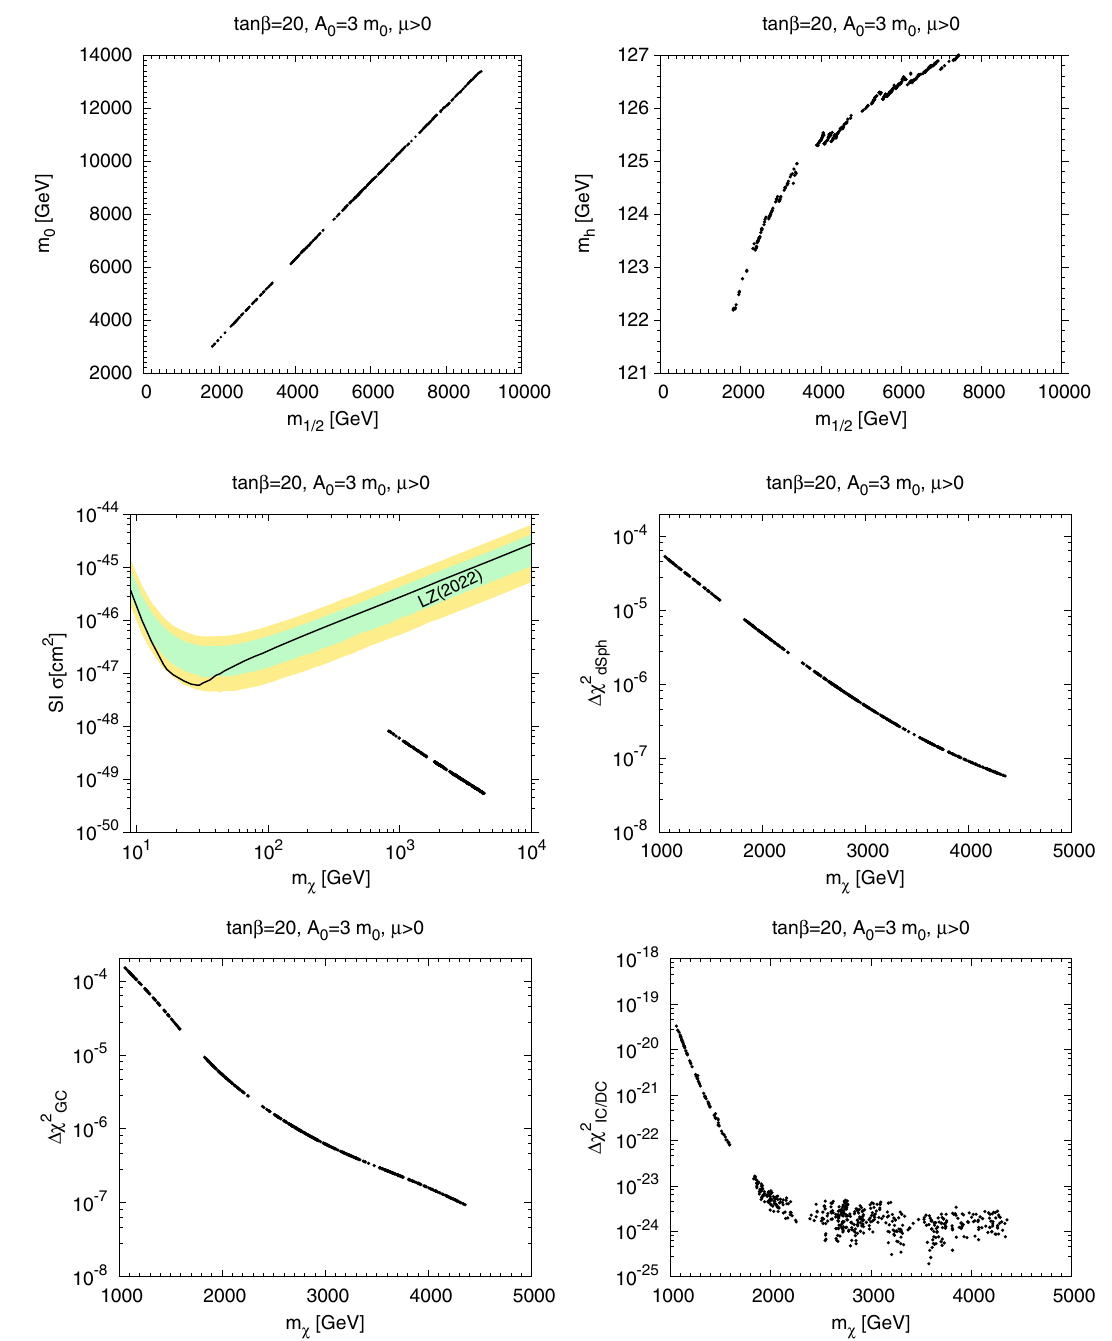
Fig. 17 The dark matter strip, m h constraint, spin-independent direct scattering constraint, (cid:7)χ 2 from Fermi -LAT dSph and H.E.S.S. GC γ -ray and Icecube solar ν signals for the case tan β = 20, A 0 = 3 m 0 and μ >